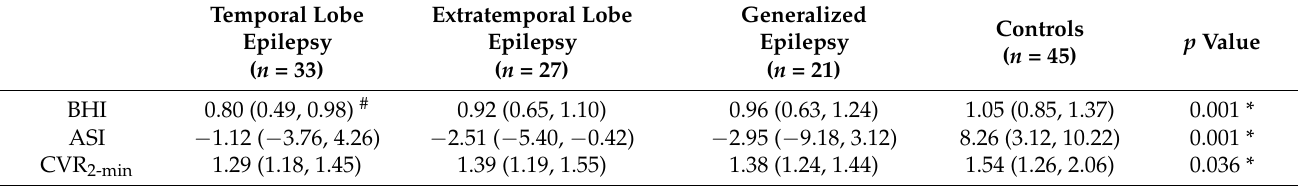
Table 6. Comparison of cerebral hemodynamics in the three different forms of epilepsy and in the controls. Temporal